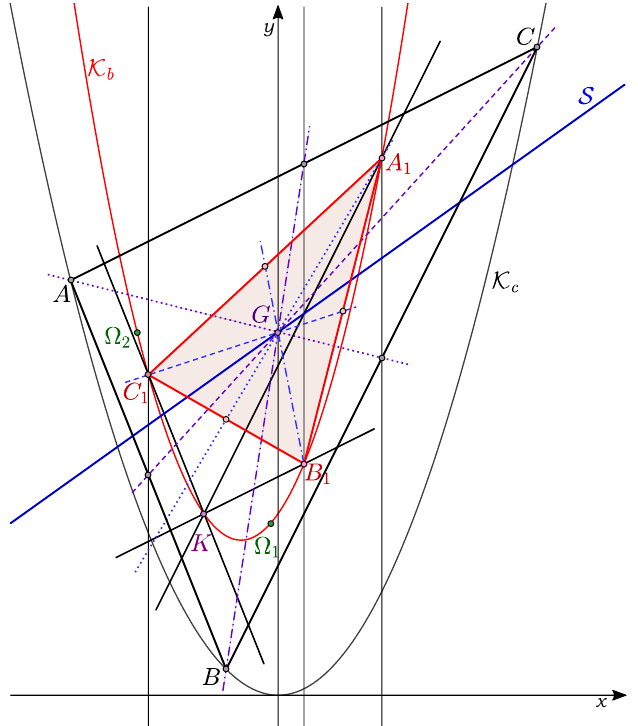
Figure 1. Brocard circle K b , the Steiner axis S , and the first Brocard triangle A 1 B 1 C 1 of the triangle ABC . Visualization of statements of Theorems 1, 3 and